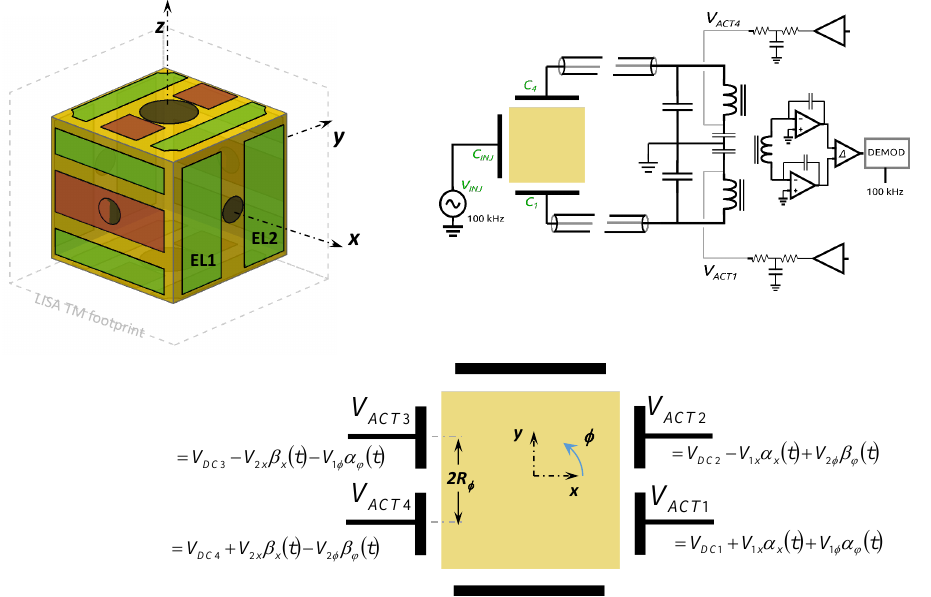
Figure 2. Sketch of strawman electrode housing and TM, with associated sensing and actuation electronics at upper right and, lower right, X face electrode actuation configuration for x forces and φ